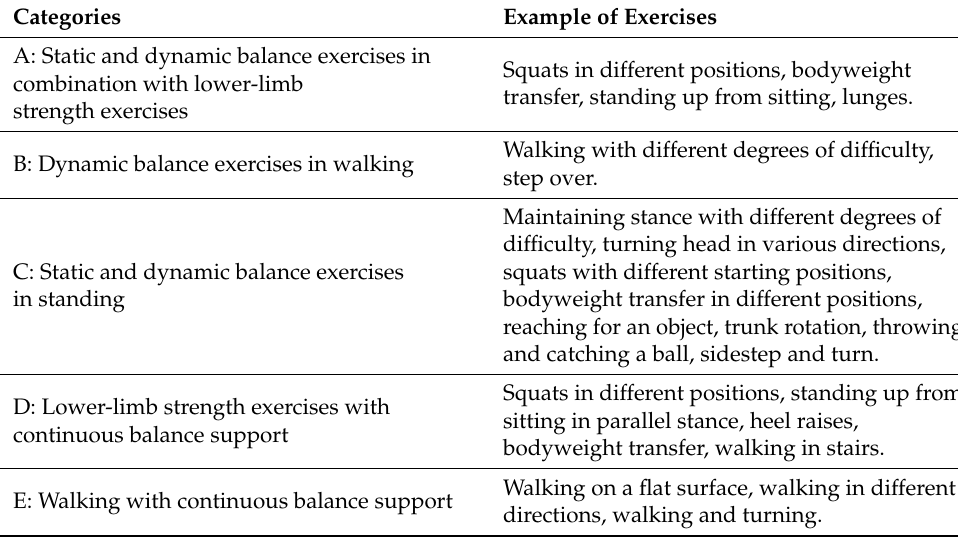
Table 1. Categories and examples of HIFE exercises.